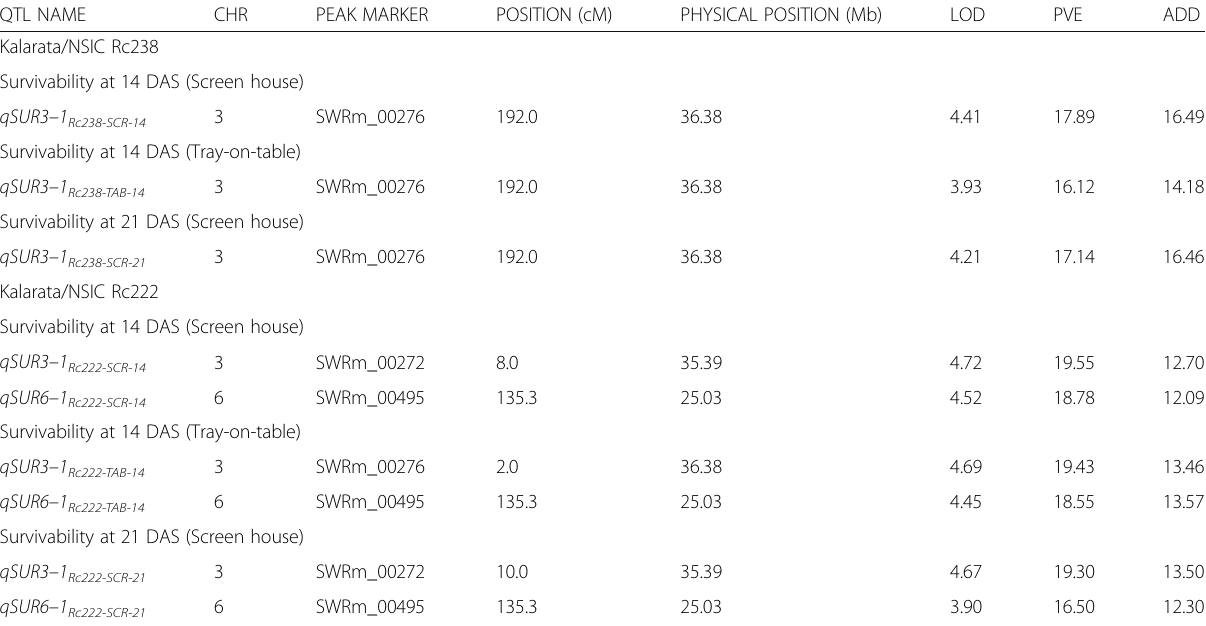
Table 4 List of QTLs Detected for Survivability in the BC 1 F 2:3 Population of Kalarata and NSIC Rc238 and Kalarata and NSIC Rc222 Using White-Colored Grain